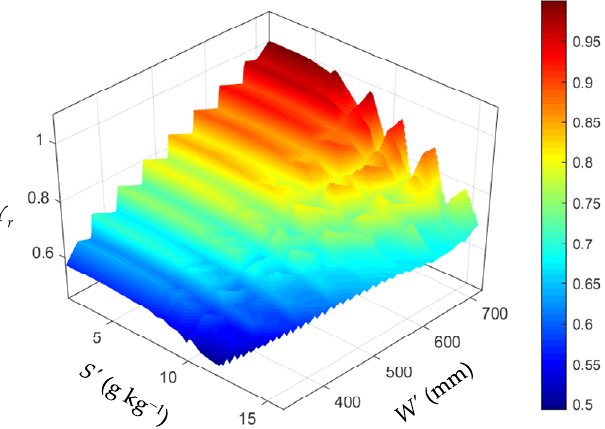
Figure 4. Relationship between Y r (relative yield) () and S’ (total salt content of soil) and W’ (available water for the entire crop growth period) in different scenarios.